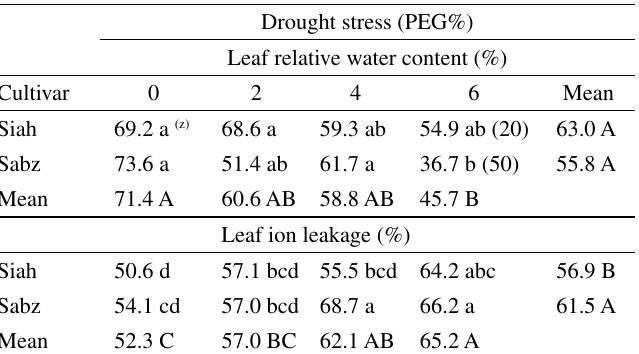
Table 3 - Interaction of water stress and cultivar on leaf relative water content (%) and leaf ion leakage (%) Drought stress (PEG%)